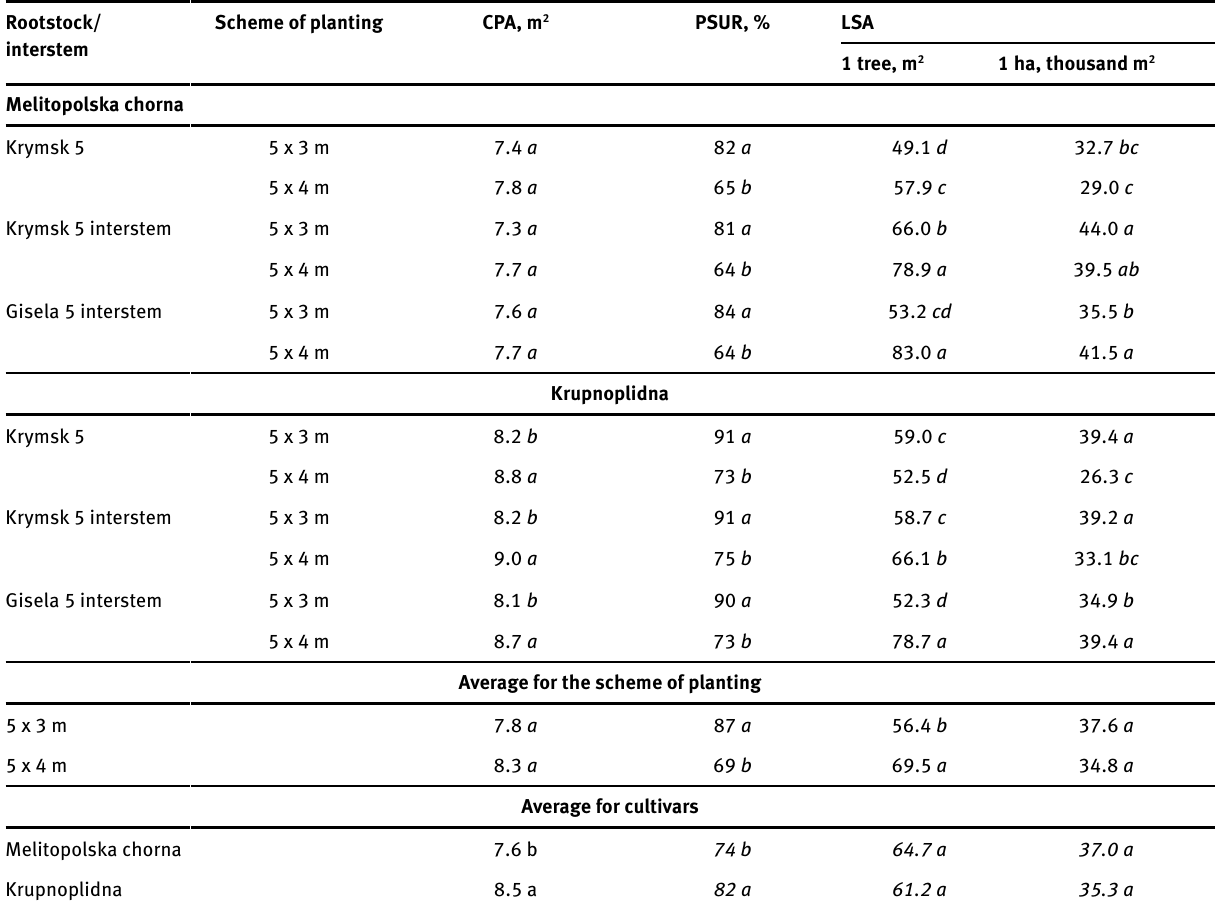
Table 1: Influence of interstems and plant density on canopy projected area and leaf surface area of sweet cherry trees, average for 2016-2017 Rootstock/